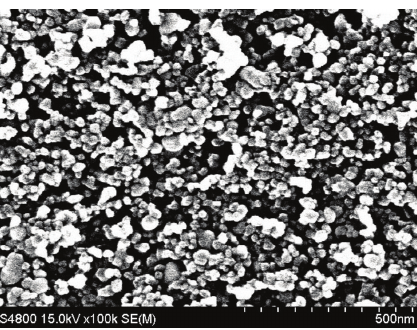
Figure 1: The FESEM image of the morphology of the TiO 2 thin films.